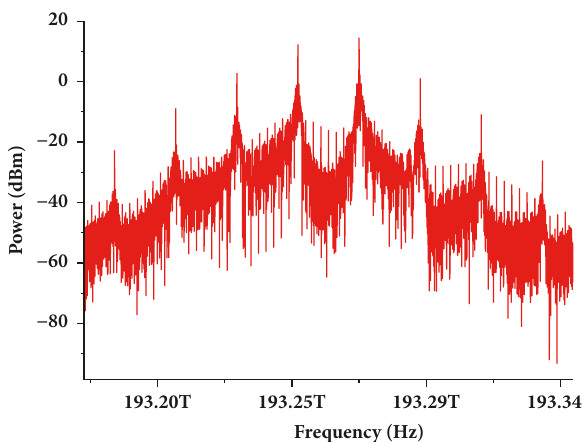
Figure 3: Optical spectrum after DP-MZM.